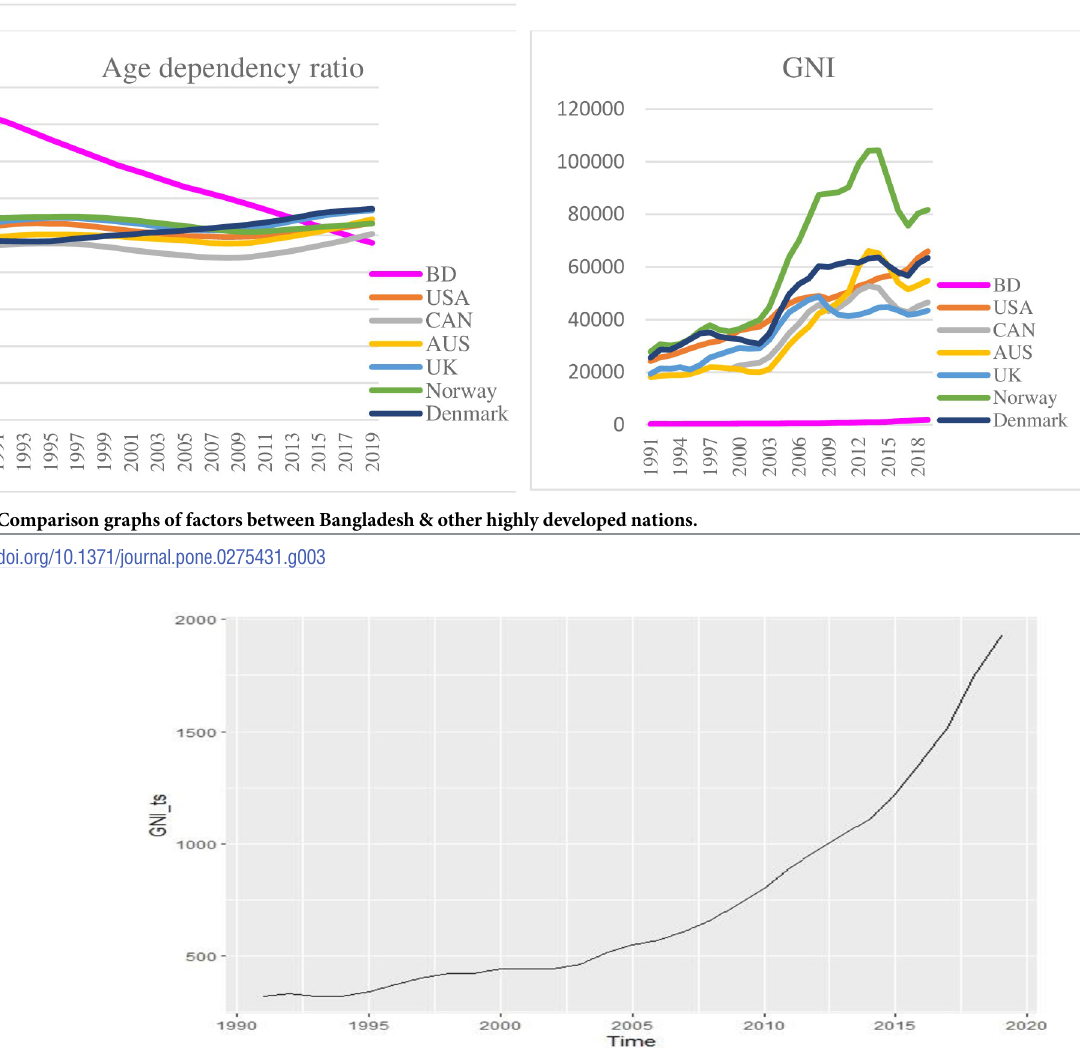
Fig 4. Time series plot of